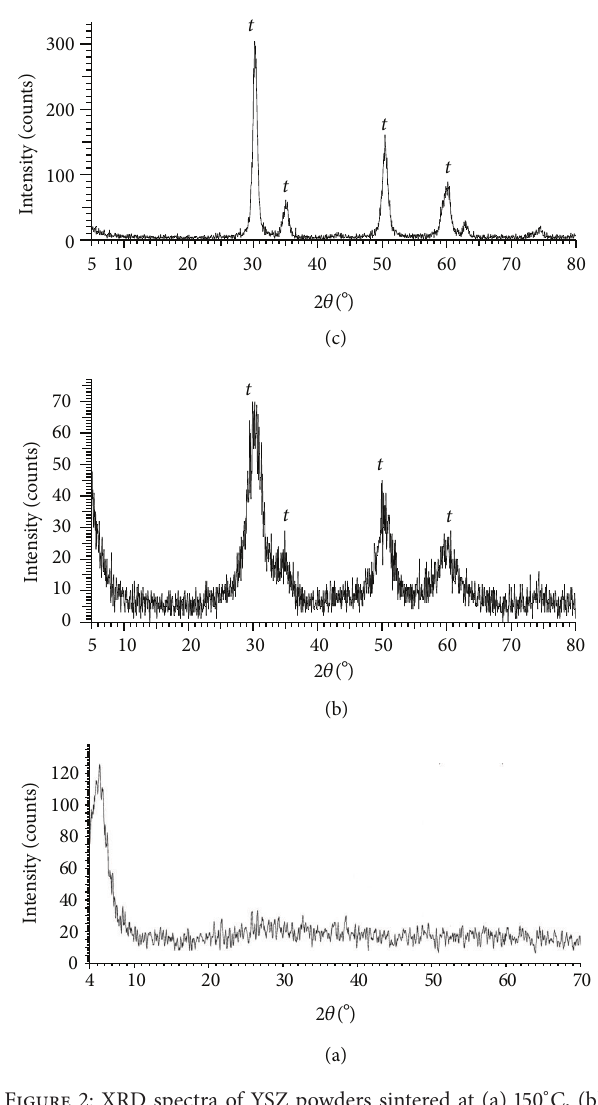
Figure 2: XRD spectra of YSZ powders sintered at (a) 150 ∘ C, (b) 400 ∘ C, and (c) 700 ∘ C. The amorphous to crystalline transformation from 150 ∘ C to 400 ∘ C is clearly shown. The intensity of peaks increases from 400 ∘ C to 700 ∘